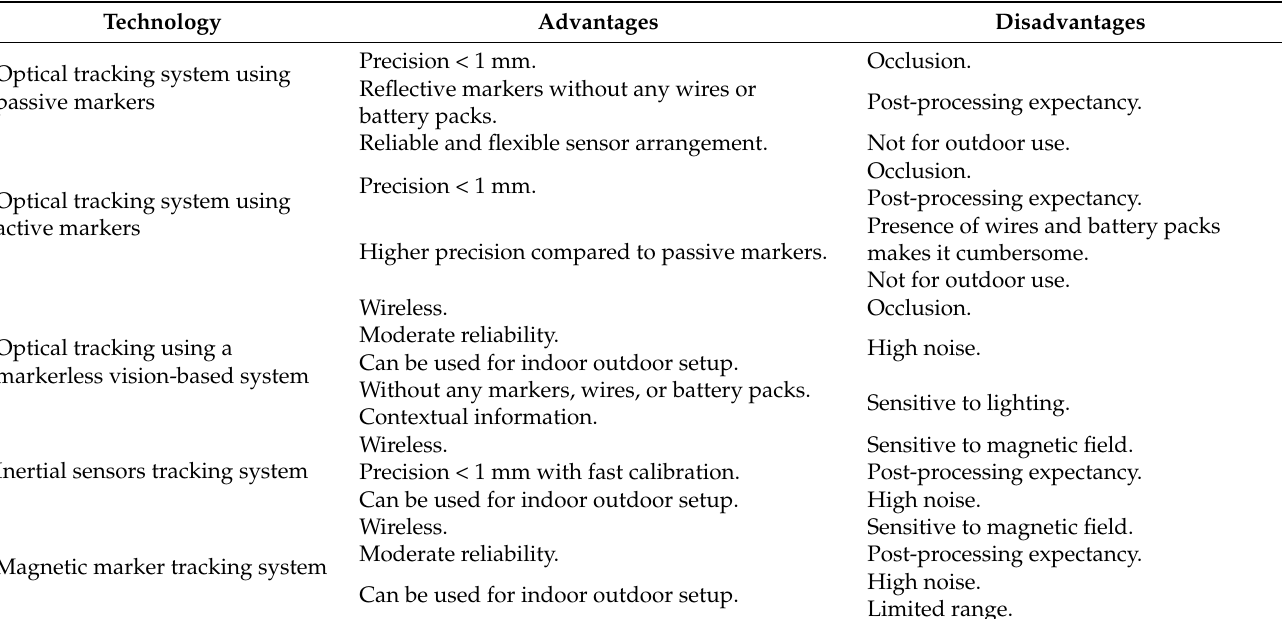
Table 1. Key Features of the Various Types of Motion Capture